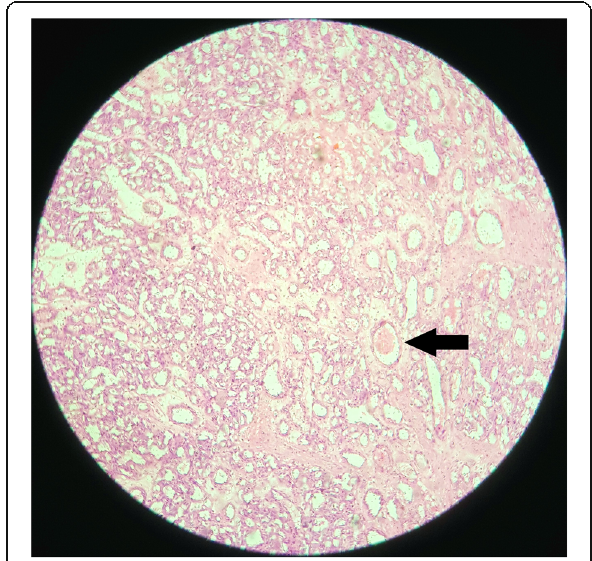
Fig. 3 Biopsy of parotid gland showing hemangioma. Black arrow indicates endothelium-lined channel filled with blood, characteristic of hemangiomas. × 10